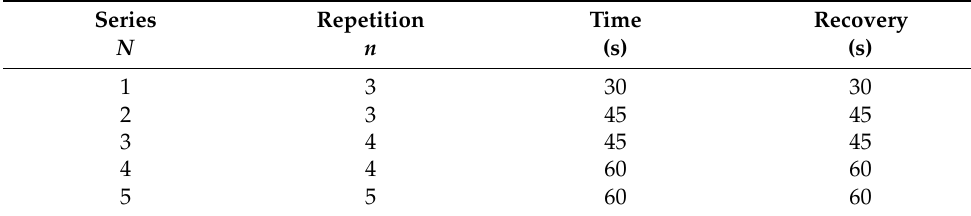
Figure 3. Calf muscle stretching exercise 2.